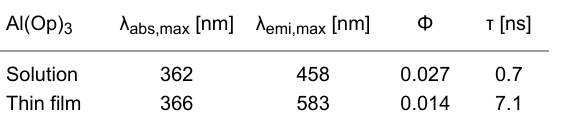
Table 1: Photophysical properties of Al(Op) 3 in CH 2 Cl 2 solution and in the thin film at room temperature. Al(Op) 3